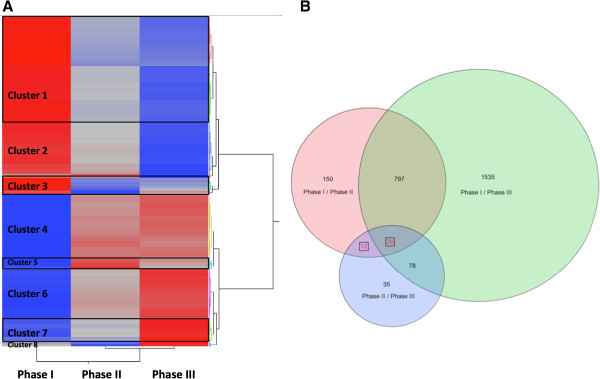
Clustering analysis of 2, 633 differentially expressed contigs. (A) Hierarchical clustering of 2,633 differentially expressed transcript abundance in Phases I, II and III of H2 photoproduction; and (B) Venn Diagram of the distribution of differentially expressed transcripts among the three different phases of H2 photoproduction.